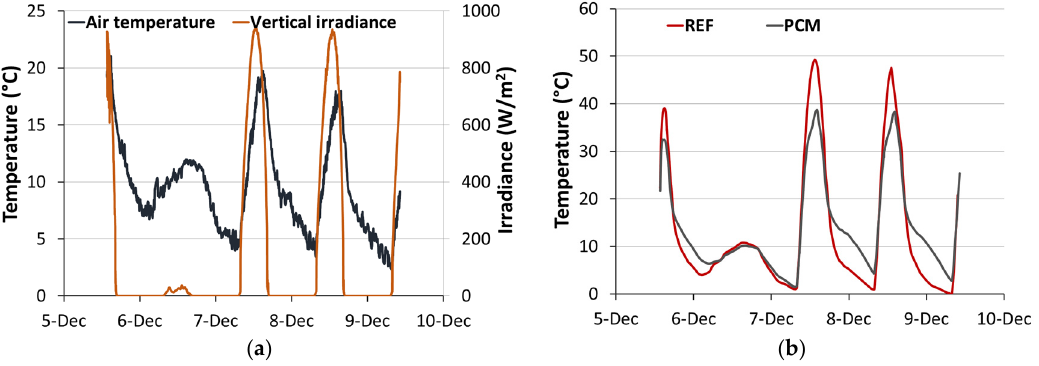
Figure 6. Experimental data from the cold season monitoring campaign: ( a ) trends of outdoor air temperature and global irradiance on a vertical plane; ( b ) trends of air temperature inside the REF box and the PCM box during the test.